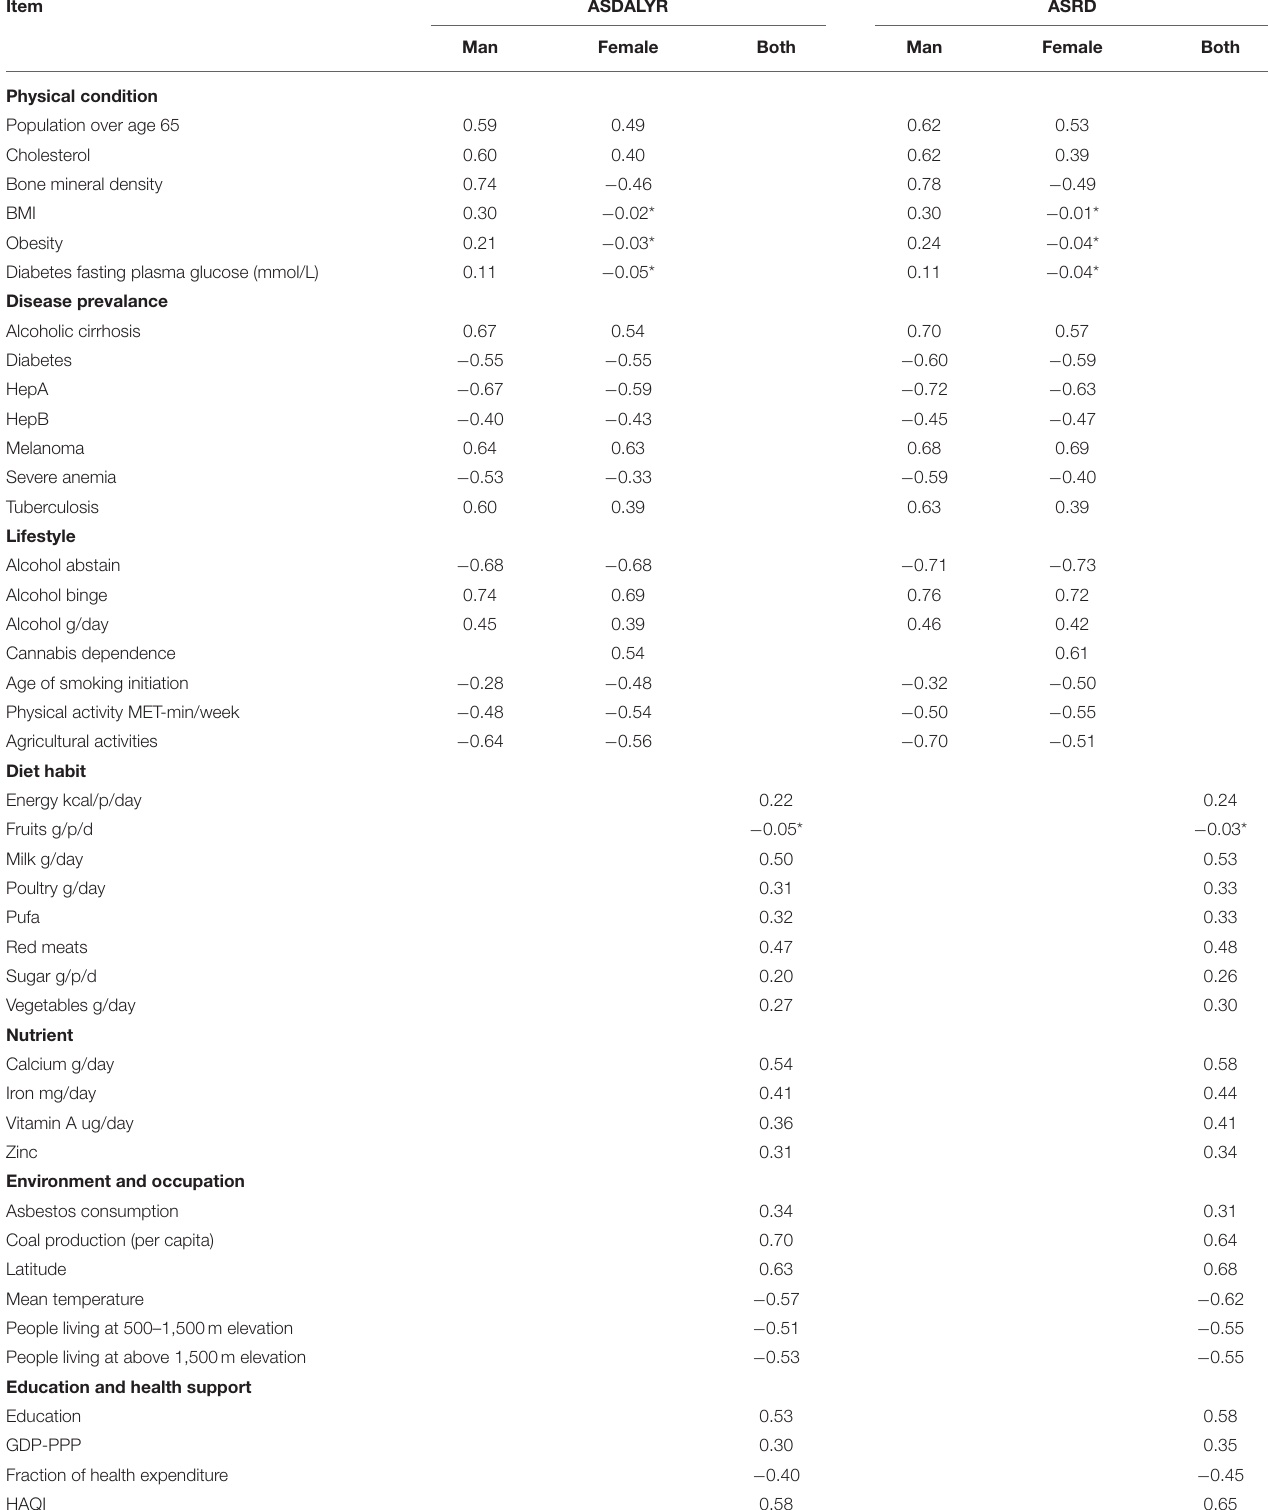
TABLE 1 | The relevant factors of aortic aneurysm burden in 2019. Item ASDALYR ASRD Man